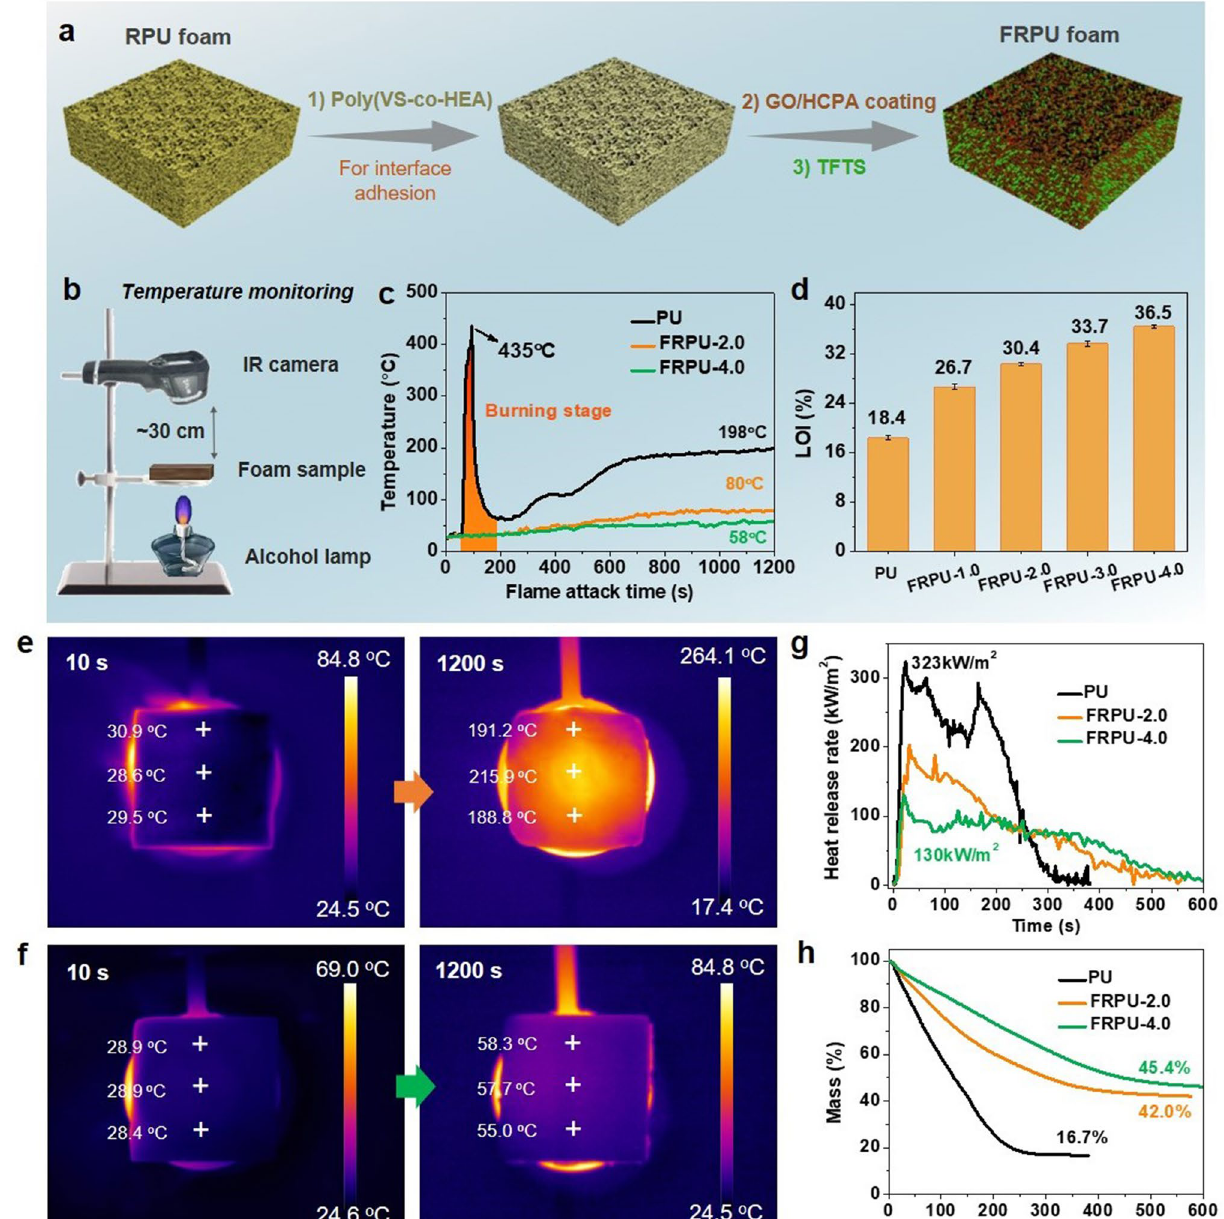
Fig. 5 Flame‑retardant coatings application to RPU foam. a Schematic illustration for the fabrication process of flame‑retardant RPU foam (FRPU). b Homemade setup for determining real‑time temperature changes of PU foam samples during combustion process and. c Top‑surface temperature of PU and FRPU samples as a function of flame attack time. d LOI values of various PU foam samples. Infrared images of e PU foam and f FRPU‑4.0 exposed to the flame attack for 10 and 1200 s. g HRR and h mass as a function of time of various foam